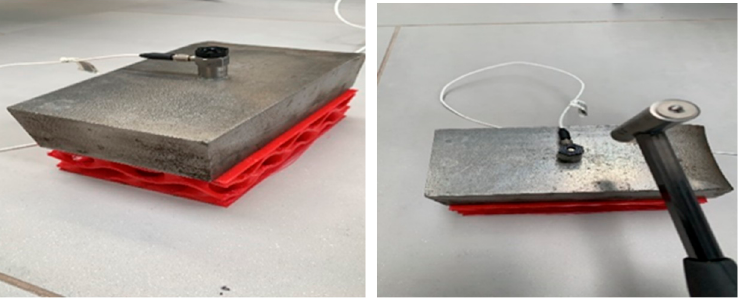
Figure 7. Test setup of the single mass-spring 3DPPBB system used to verify the experiments.